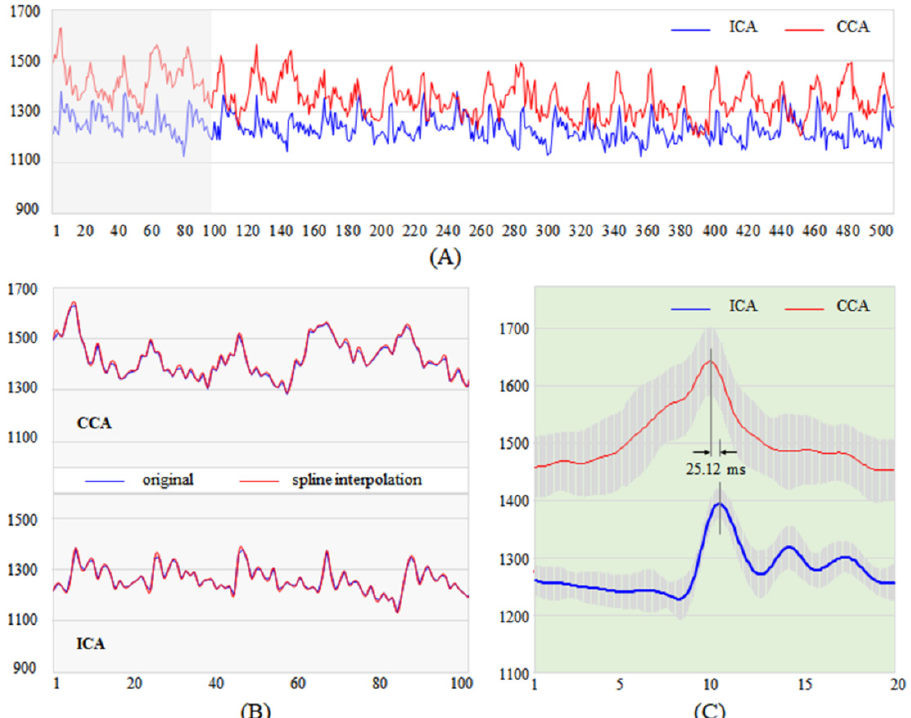
Figure 4. Pulse waveforms of CCA and ICA. ( A ) CCA (red) and ICA (blue) pulse waveforms consisted of 500 measurements for 24 s using SMS-K technique. ( B ) The pulse waveforms (blue) for the section of 100 measurement and the interpolated waveforms (red) of CCA and ICA. ( C ) Average pulse waveforms. The mean transit time of 5 sections between CCA and ICA was presented. Abbreviations: CCA, common carotid artery; ICA, internal carotid artery; SMS-K, simultaneous multi-slice keyhole technique.